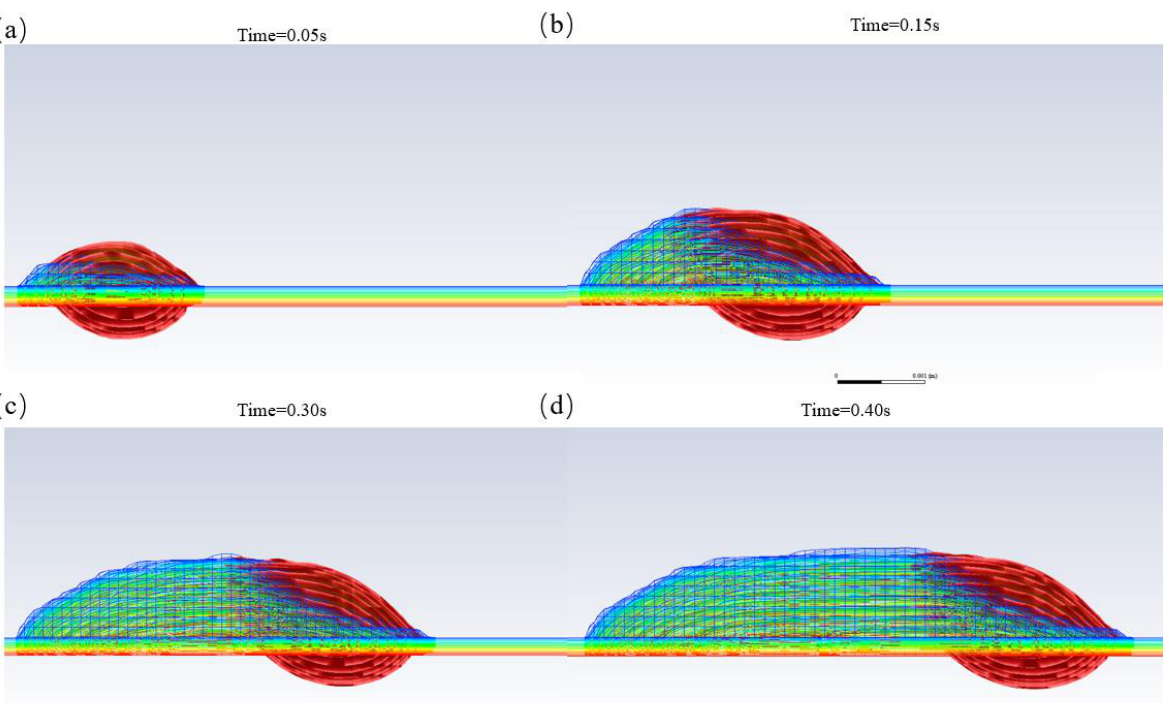
Figure 11. Three dimensional molten pool morphology of single path forming at different moments. ( a ) 0.05 s; ( b ) 0.15 s; ( c ) 0.30 s; ( d ) 0.40 s .